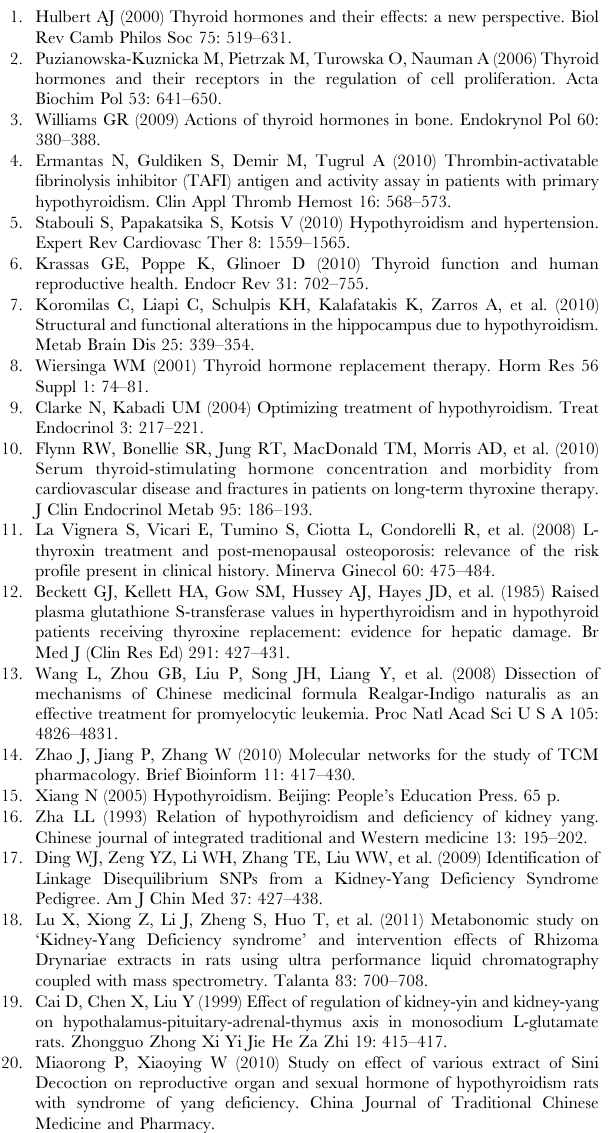
Table S3 Relative intensity of potential biomarkers